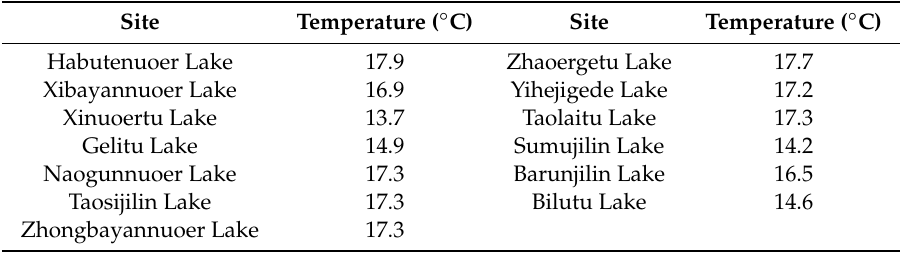
Table 5. Spring water temperature of BJD in January 2014 (Zhang et al., 2015).